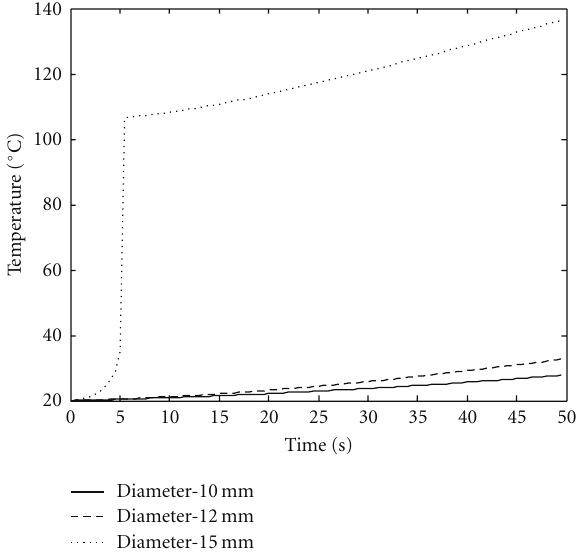
Figure 3: Dielectric properties of plant materials as a function of frequency and moisture content. Figure 4: Temperature response, at a constant microwave power density, in the centre of a cylinder of plant-based material, as a function of plant stem diameter, assuming a constant moisture loss from a moisture content of 0.87 to 0.10 during microwave